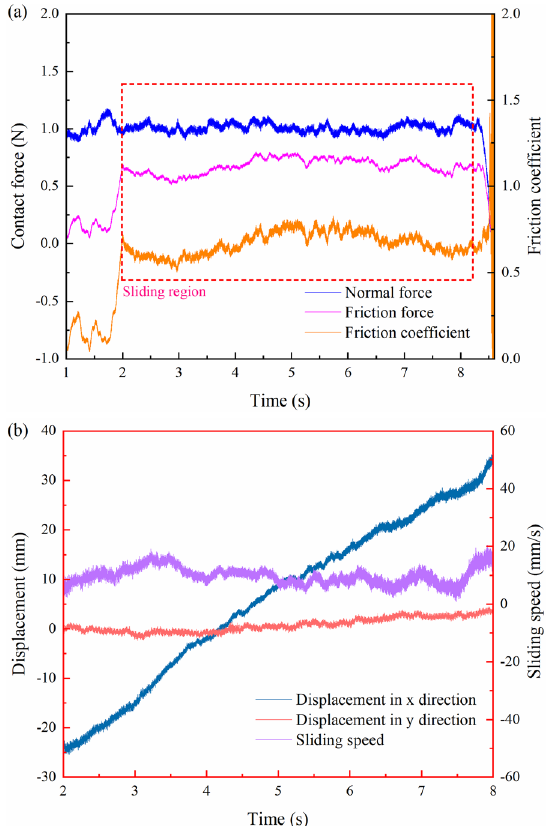
Figure 3 Analysis parameters for active sliding against PTFE#3, including ( a ) contact force and friction coefficient, ( b ) sliding displacement and sliding speed